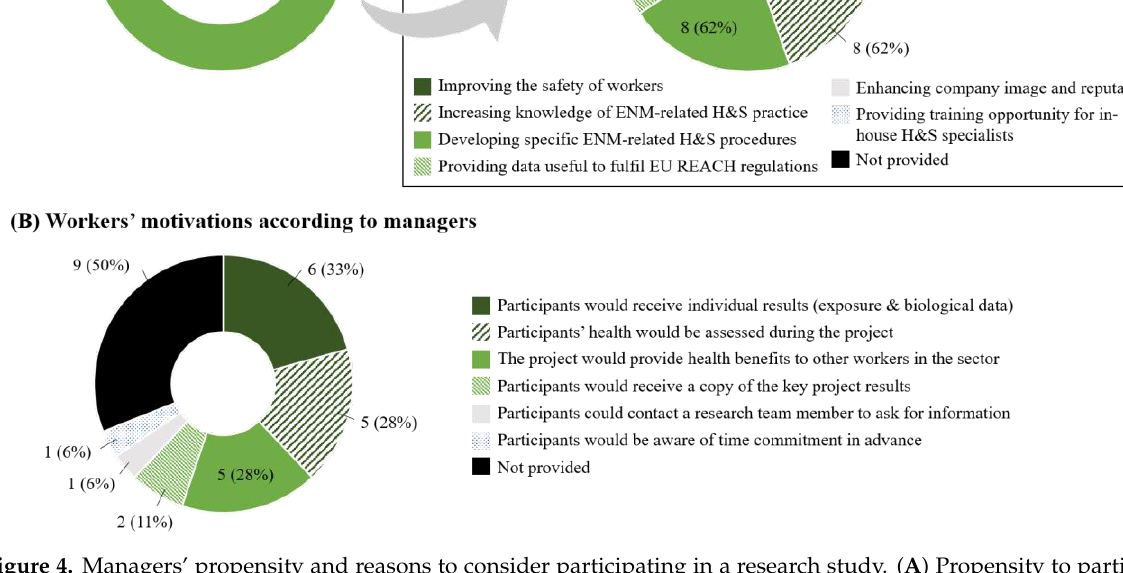
Figure 4. Managers’ propensity and reasons to consider participating in a research study. ( A ) Propensity to participate in a research study. The square box on the right panel ( n = 13) details reasons for accepting participation. ( B ) Workers’ motivations to participate in a research study according to their managers.